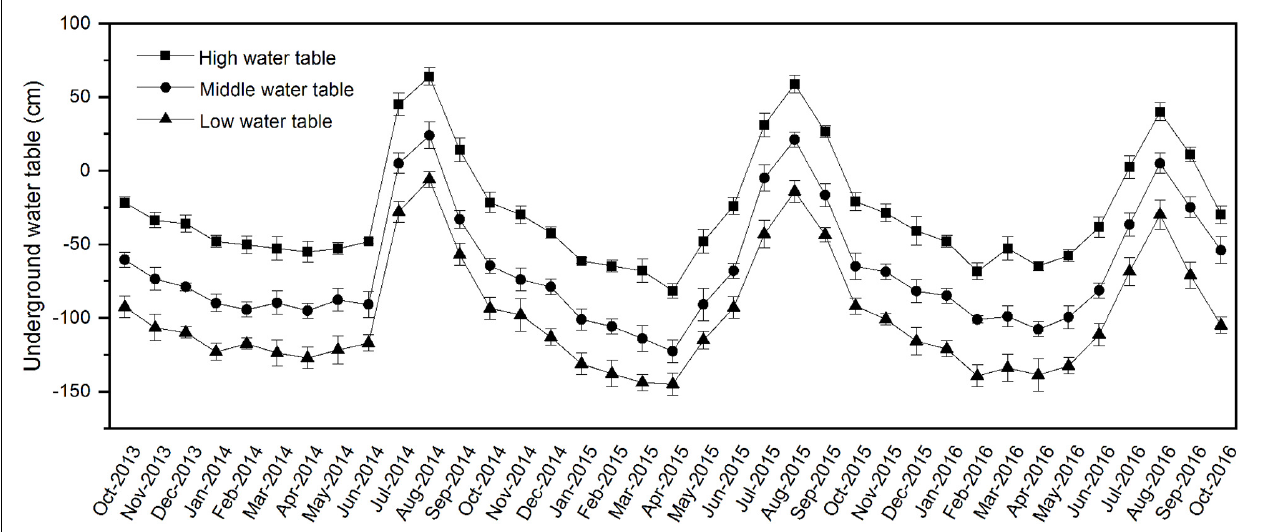
FIGURE 1 | Monthly variation of underground water table during the experimental period from October 2013 to October 2016 in different study sites. The error bars represent standard deviation (SD) of the underground water